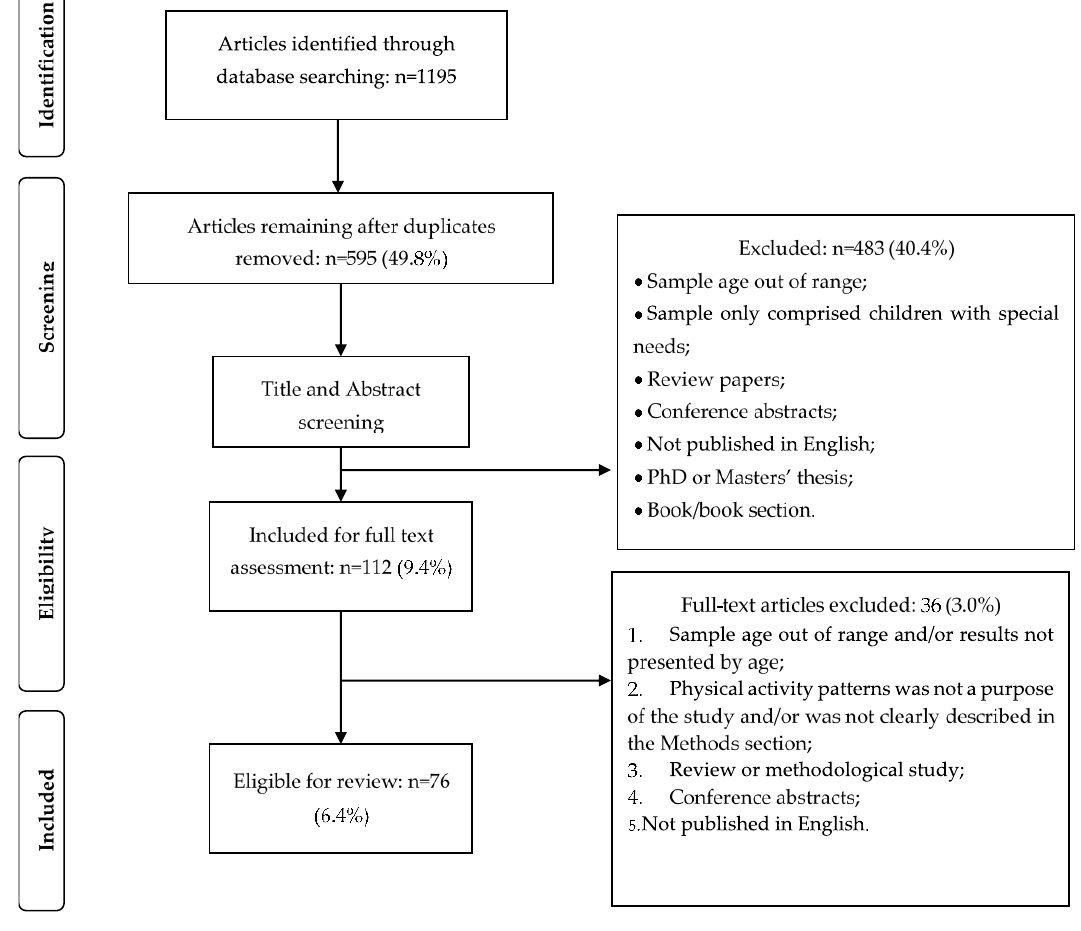
Figure 1. PRISMA flow diagram of screening process.